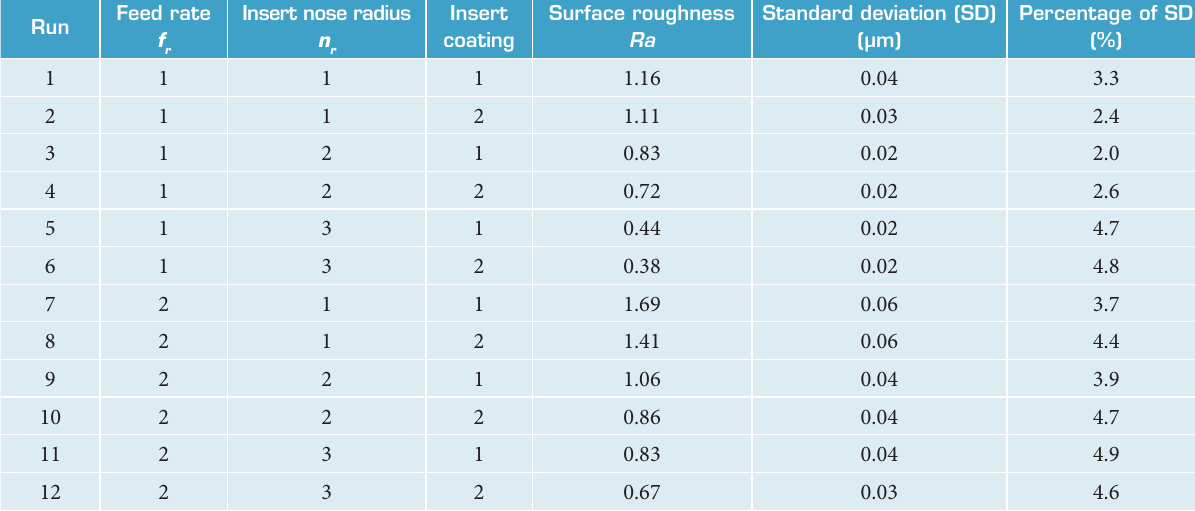
Table 2. Results in the experimental